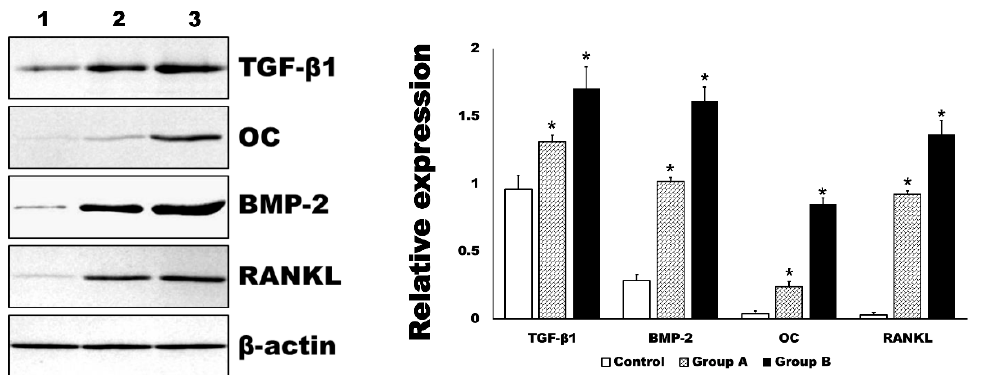
Figure 7. Western blot for tissue samples. The level of transforming growth factor- β 1 (TGF- β 1), osteocalcin (OC), bone morphogenic protein-2 (BMP-2), and receptor activator of nuclear factor kappa-B ligand (RANKL) were significantly increased in 4HR administered groups (Group A and B, * p < 0.001). The increasing of each marker was dependent on the applied dosage of 4HR (1: control for solvent only, 2: Group A-1.28 mg/kg 4HR administered, 3: Group B-128 mg/kg 4HR administered).